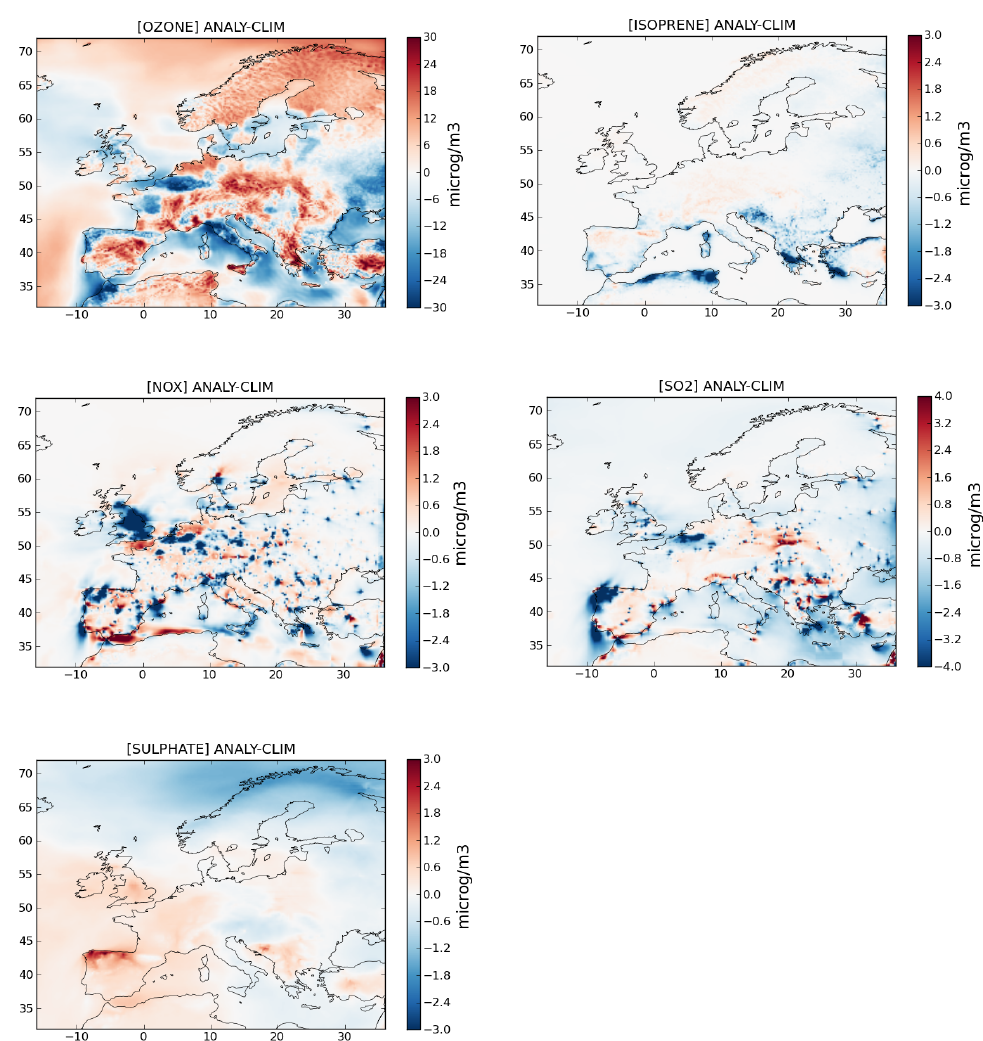
Fig. 9. Same as Fig. 6 but comparing ANALY and